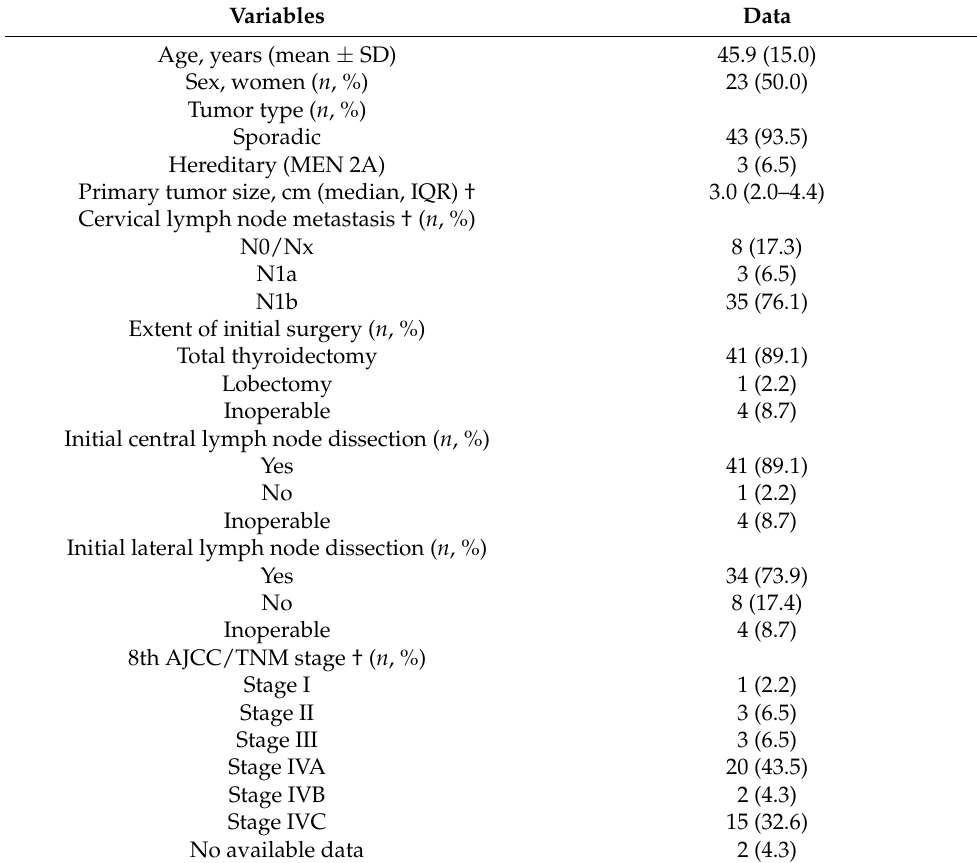
Table 1. Clinicopathological characteristics of 46 medullary thyroid carcinoma patients with distant metastasis. Variables